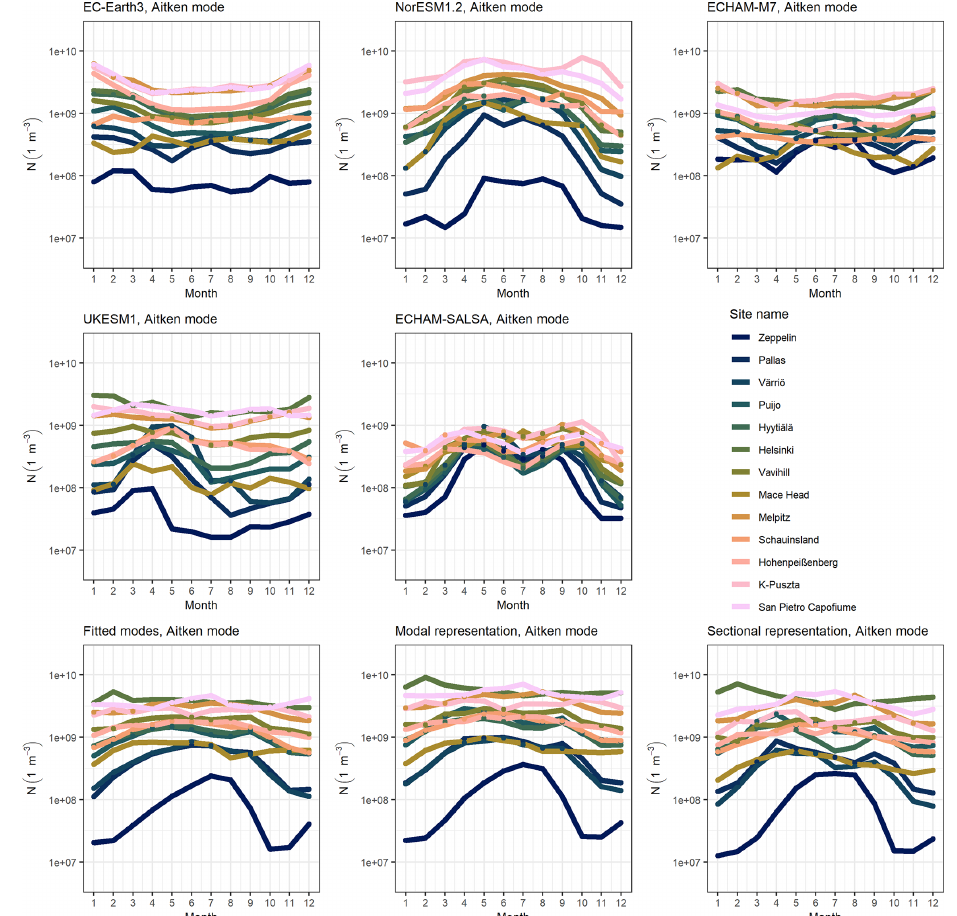
Figure 11. Seasonal cycle of Aitken mode number concentration in measurements and climate models for measurement sites. A subplot represents the seasonal cycle in one model or measurement. Coloured lines represent the median of the monthly means for Aitken mode number concentrations. Sites are ordered from most northerly to most